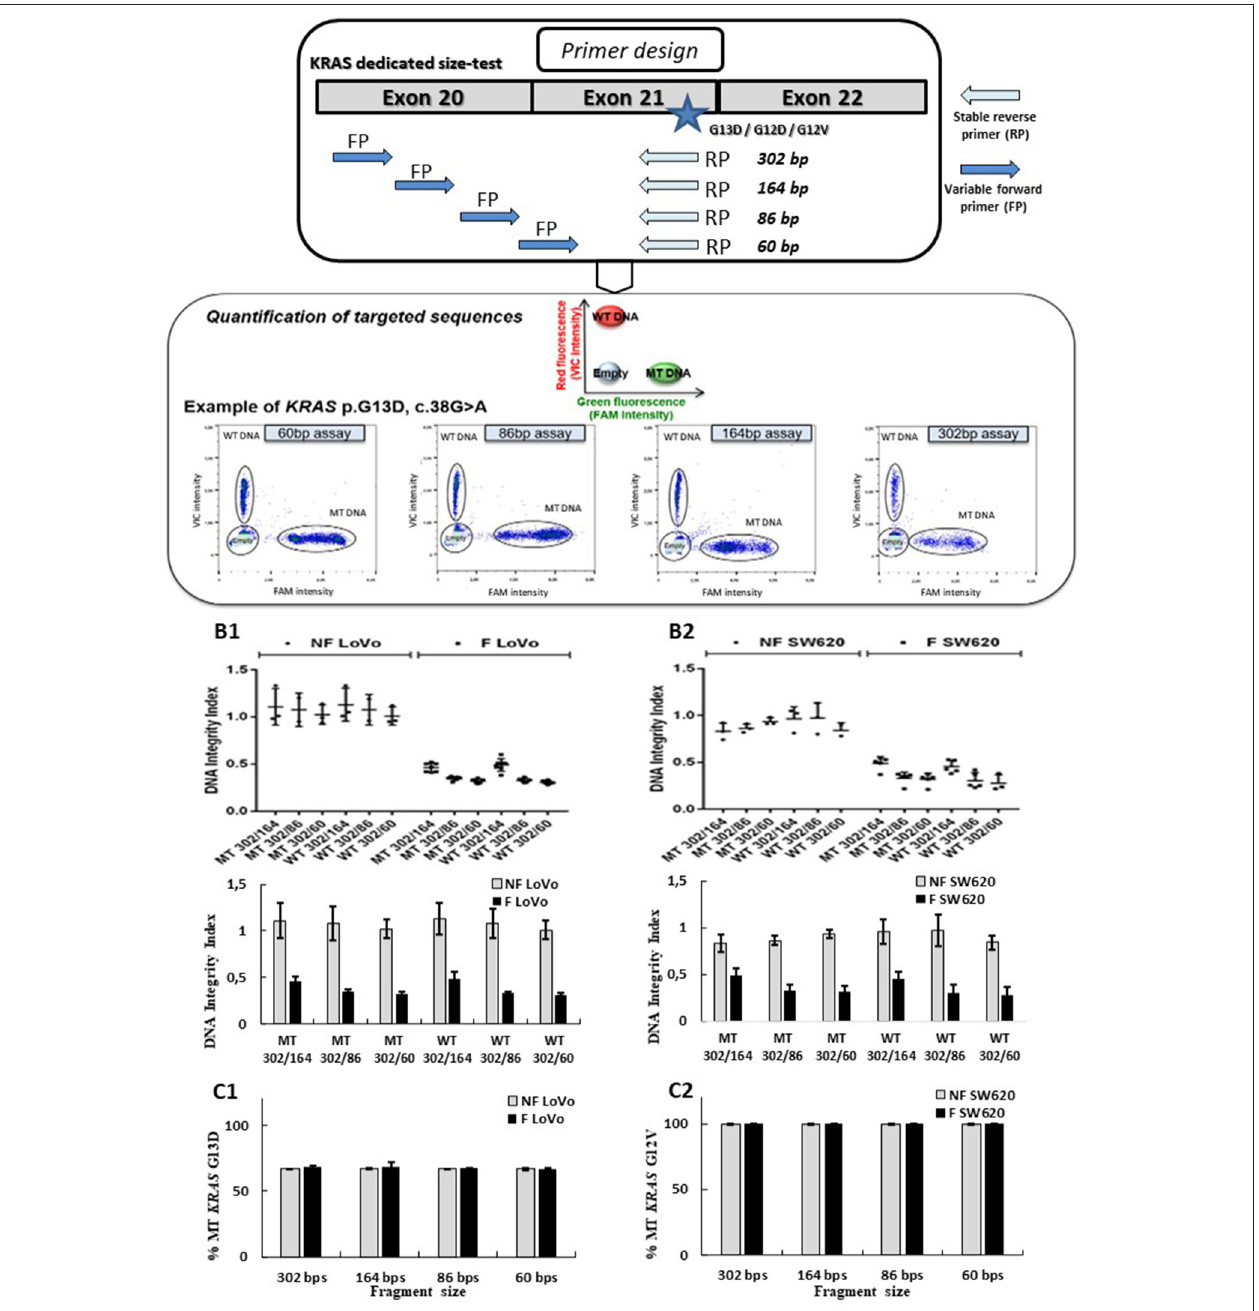
FIGURE 2 | Design and validation of ddPCR assays for ccfDNA integrity analysis with the use of fragmented and non-fragmented cell line DNA. Droplet-based digital PCR duplex assays amplifying different sizes of KRAS wild-type (WT) and mutant (MT) fragments (60, 86, 184, and 302 bp) were designed and optimized (A) . The LOB for the 302-, 164-, 86-, and 60-bp KRAS assays were, respectively, 0, 0, 3, and 1, irrespective of the mutation status. Fragmented (F) and non-fragmented (NF) DNA from LoVo ( B1 , C1 ) and SW620 CRC line ( B2 , C2 ) were used. DNA integrity index (DII) were analyzed using 302 bp amplicon (corresponding to the long fragments) and 60, 84, and 184 bp amplicons as short fragments ( B1 , B2 ). Percentage of KRAS -mutated alleles for F and NF DNA of each cell lines are given in ( C1 , C2 ). Nevertheless, PCR efficiency of the primers has not been determined by qPCR for each amplicon size on fragmented and unfragmented DNA.